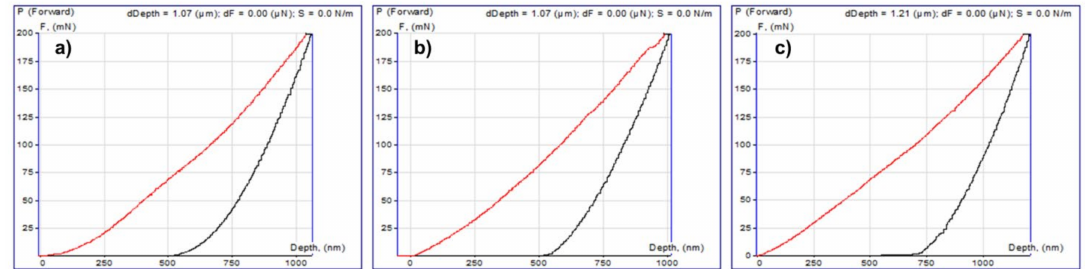
Figure 7. Loading–unloading curves for Ti–Si–C coatings obtained at a different explosive gas mixture filling volumes of the detonation gun barrel: ( a ) 50%; ( b ) 60%; ( c )